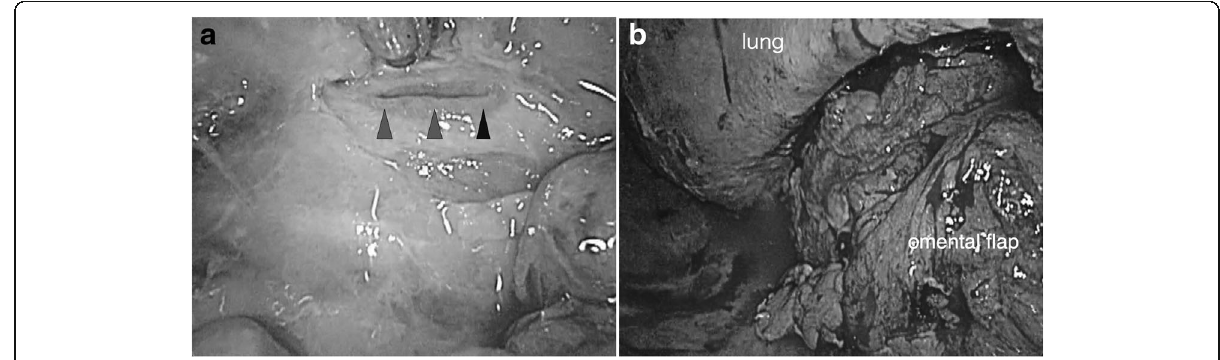
Fig. 3 Intraoperative findings. a Thoracoscopic findings revealed a small longitudinal tear in the lower portion of the esophagus (black arrowheads). b An omental pedicle flap was transferred to the right thoracic cavity through the diaphragm, sutured around the orifice of the esophageal fistula, covering